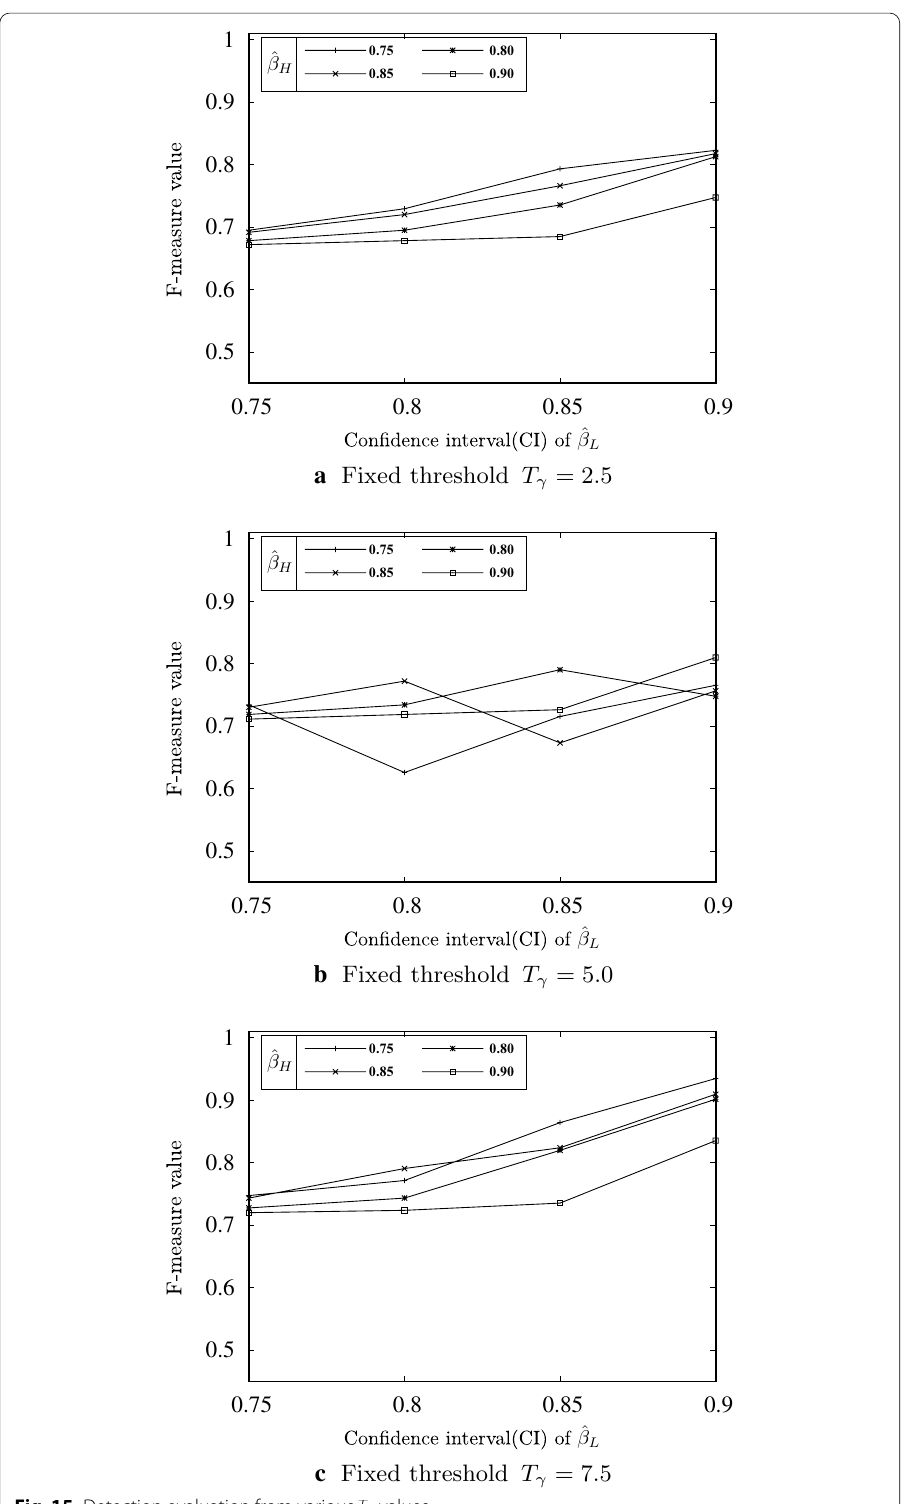
Fig. 15 Detection evaluation from various T γ